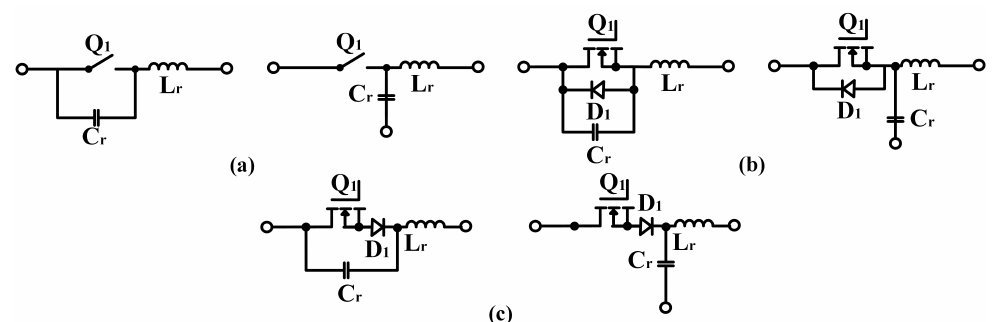
Figure 3. Voltage mode resonant switches: ( a ) m-type, l-type configurations, ( b ) half-wave mode, and ( c ) full-wave mode.